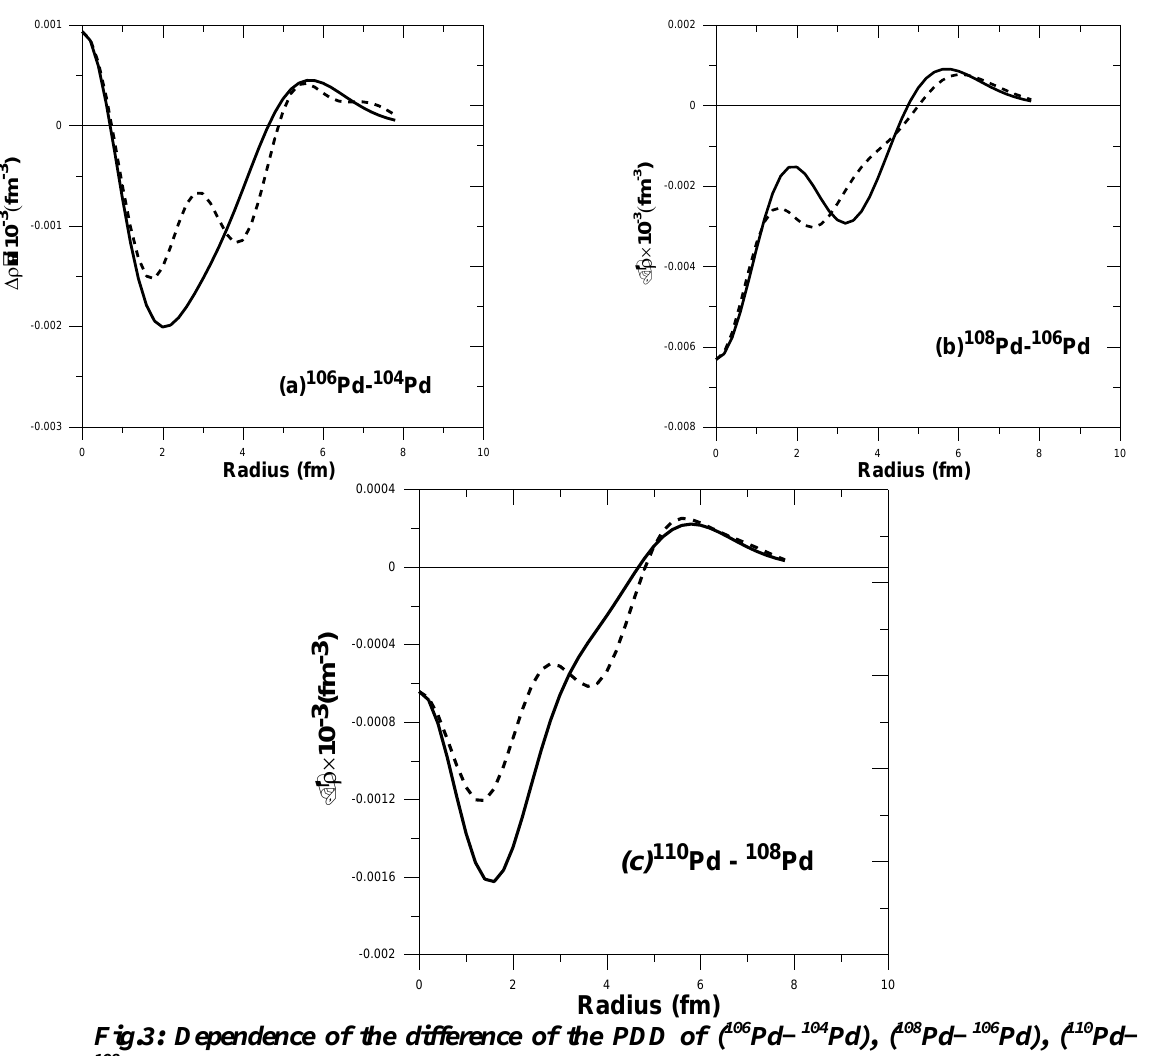
Fig.3: Dependence of the difference of the PDD of ( 106 Pd- 104 Pd), ( 108 Pd- 106 Pd), ( 110 Pd- 108 Pd) isotopes ( ) (r). The solid curves represents the calculated difference of the PDD with (d , d ), and the dashed curves are the fitted to the experimental FB data, 1 2 taken from ref.